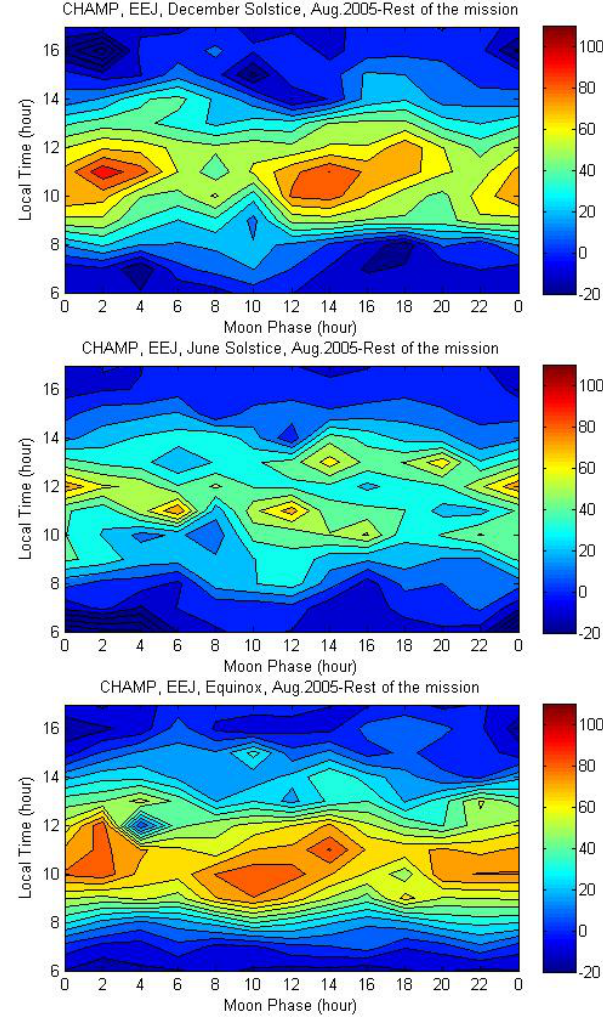
Fig. 8. The same as Fig. 4, but for the solar minimum years Aug. 2005-2010.